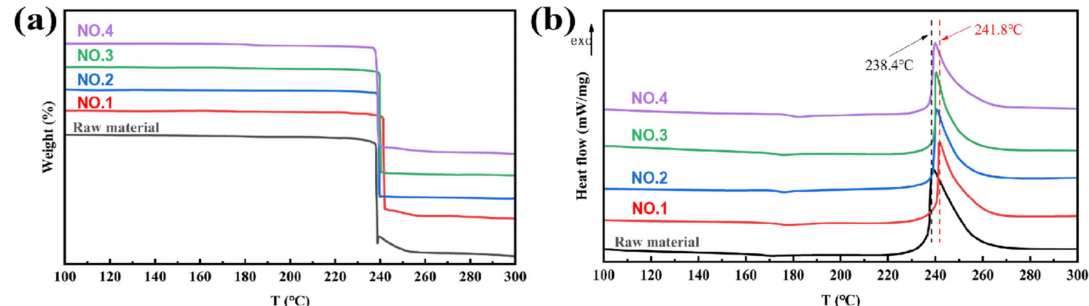
Figure 5. ( a ) TG and ( b ) DSC curves of four composite particles. Purple, green, blue and red lines represent samples of NO.1, NO.2, NO.3 and NO.4